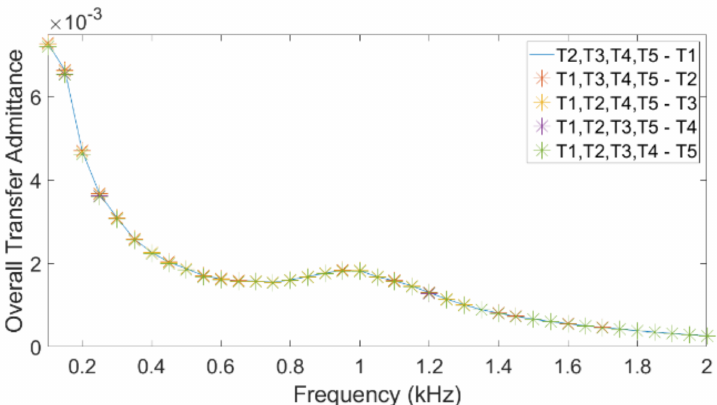
Figure 5. Overall transfer admittance (A/V) between turbines: 5-turbine plant.